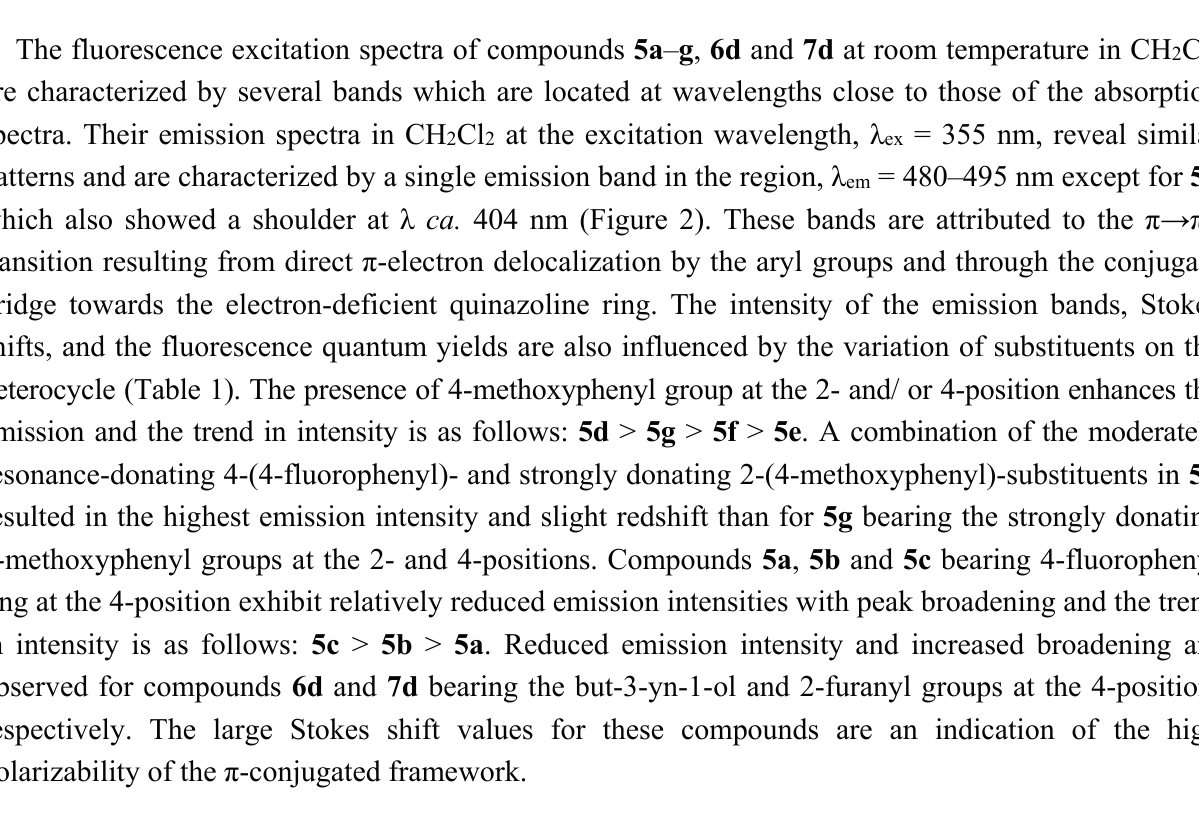
Figure 1. Absorption spectra of 5a – g , 6d and 7d in CH 2 Cl 2 (r.t.) at 2.25 × 10 − 5